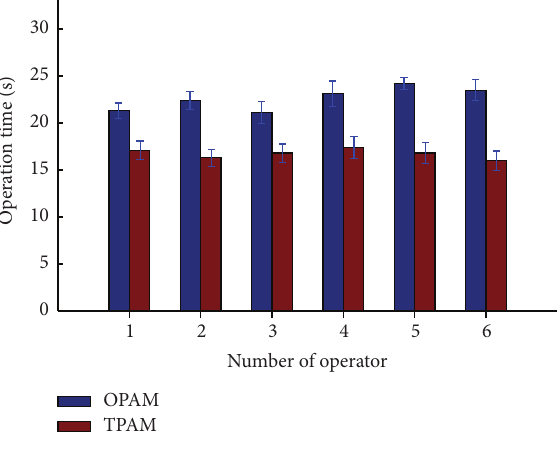
Figure 7: Operation